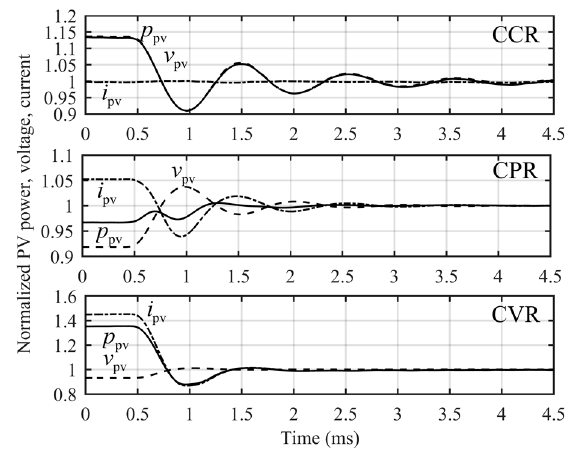
Figure 16. Effect of a step change in the duty ratio of an open-loop operated DC-DC converter on PV-generator voltage (dashed line), current (dash-dotted line), and power (solid line) as per-unit curves, when the PV-generator operating point lies in CCR, CPR, and CVR.